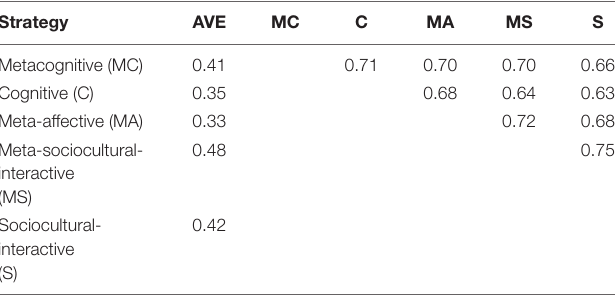
TABLE 4 | Average variance extracted (AVE) and inter-correlations for the 5-factor correlated